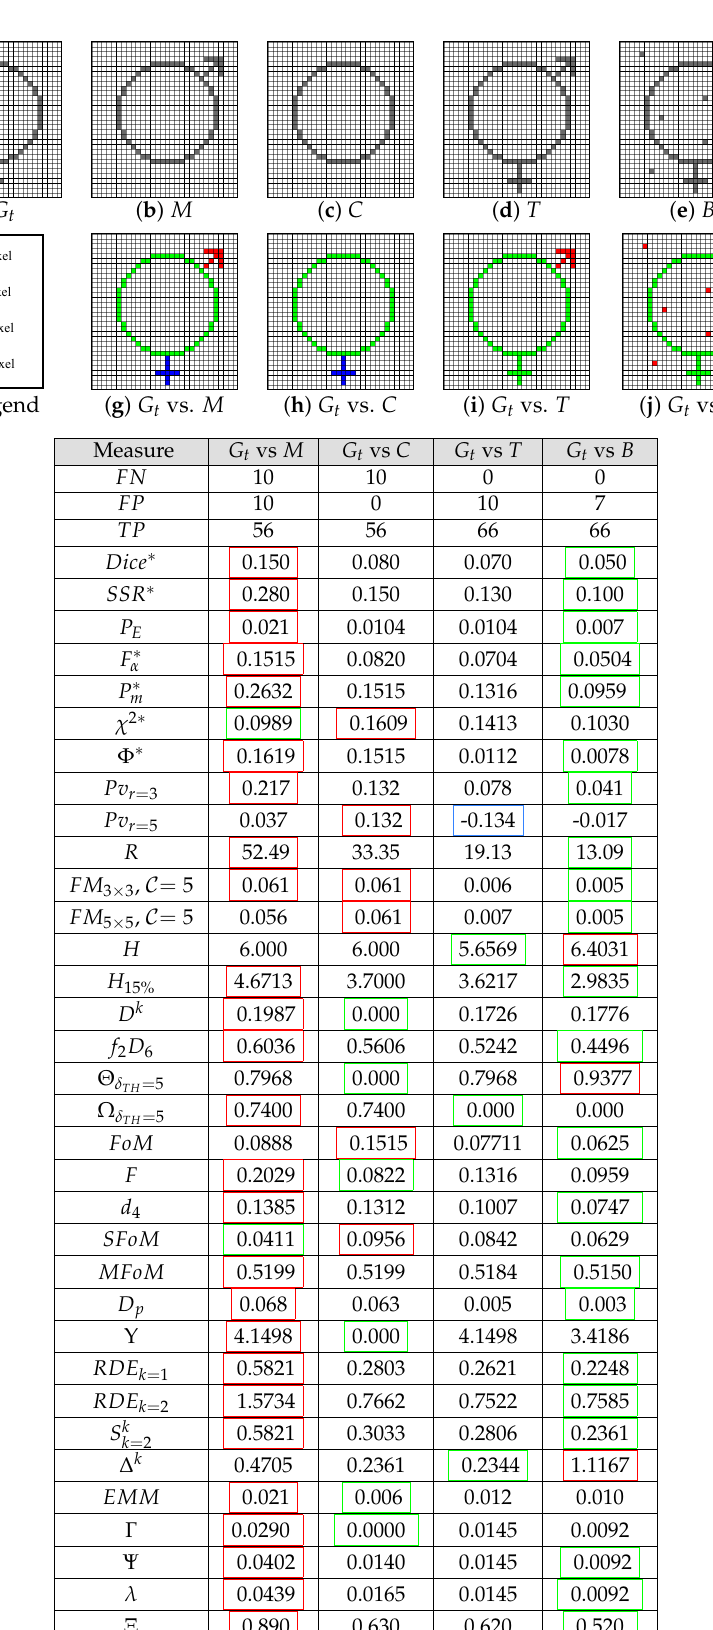
Figure 10. Evaluation measure results for different D c images in ( b – e ) using the same G t in ( a